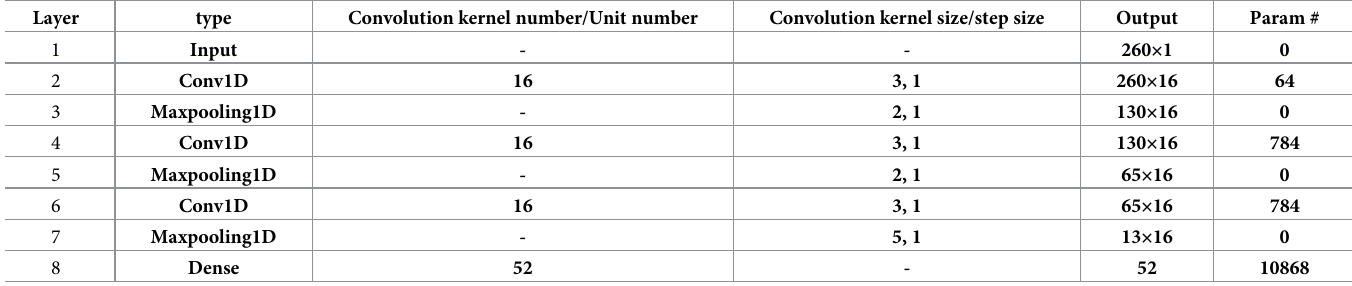
Table 2. Detailed parameters of the compression network at CR =